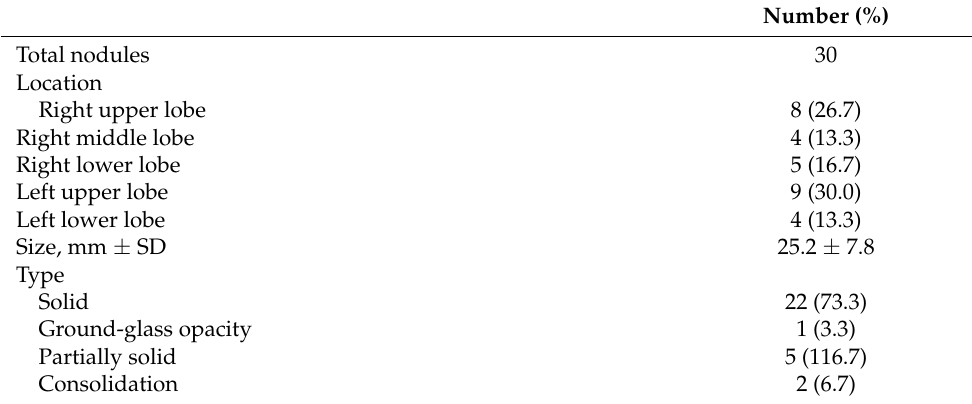
Table 2. Baseline characteristics of the pulmonary